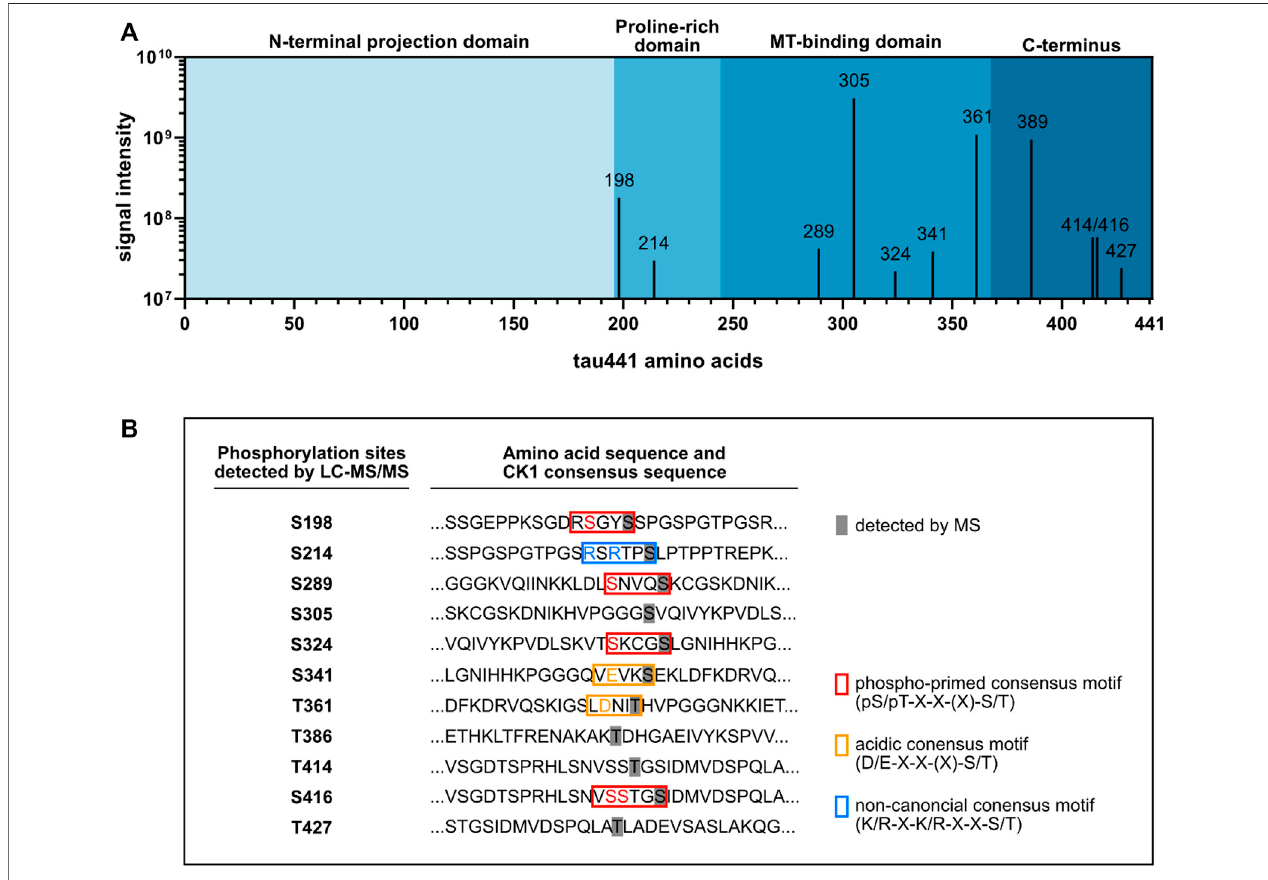
FIGURE 2 | LC-MS/MS analysis identi fi ed ten tau441 phosphorylation sites targeted by CK1 δ . Tau441 was recombinantly produced and used for in vitro phosphorylation by CK1 δ . Phosphorylated tau441 was digested with trypsin and analyzed by LC-MS/MS. (A) Results of the LC-MS/MS analysis identi fi ed ten tau441 phosphorylation sites targeted by CK1 δ mainly located in the MT-binding domain and the C-terminus of tau441. (B) Sequences of tau including the detected phosphorylation sites. Detected phosphorylation sites are covered in grey. Phospho-primed, acidic or non-canonical consensus motifs of CK1 are marked in red, orange and blue, respectively.